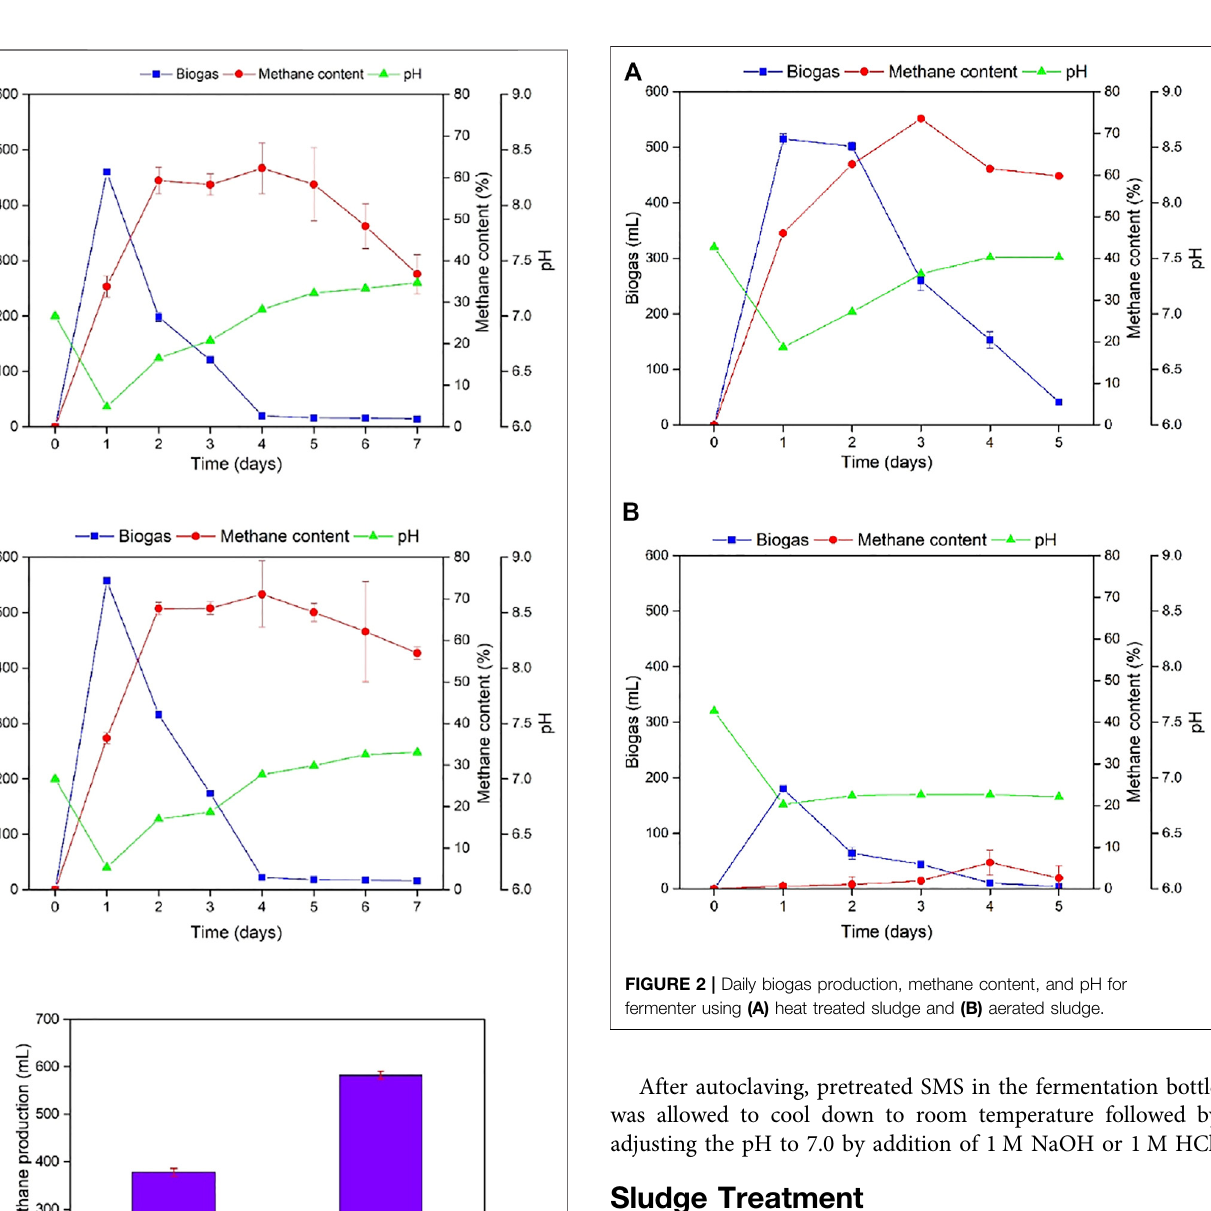
most favorable for pretreatment of SMS.